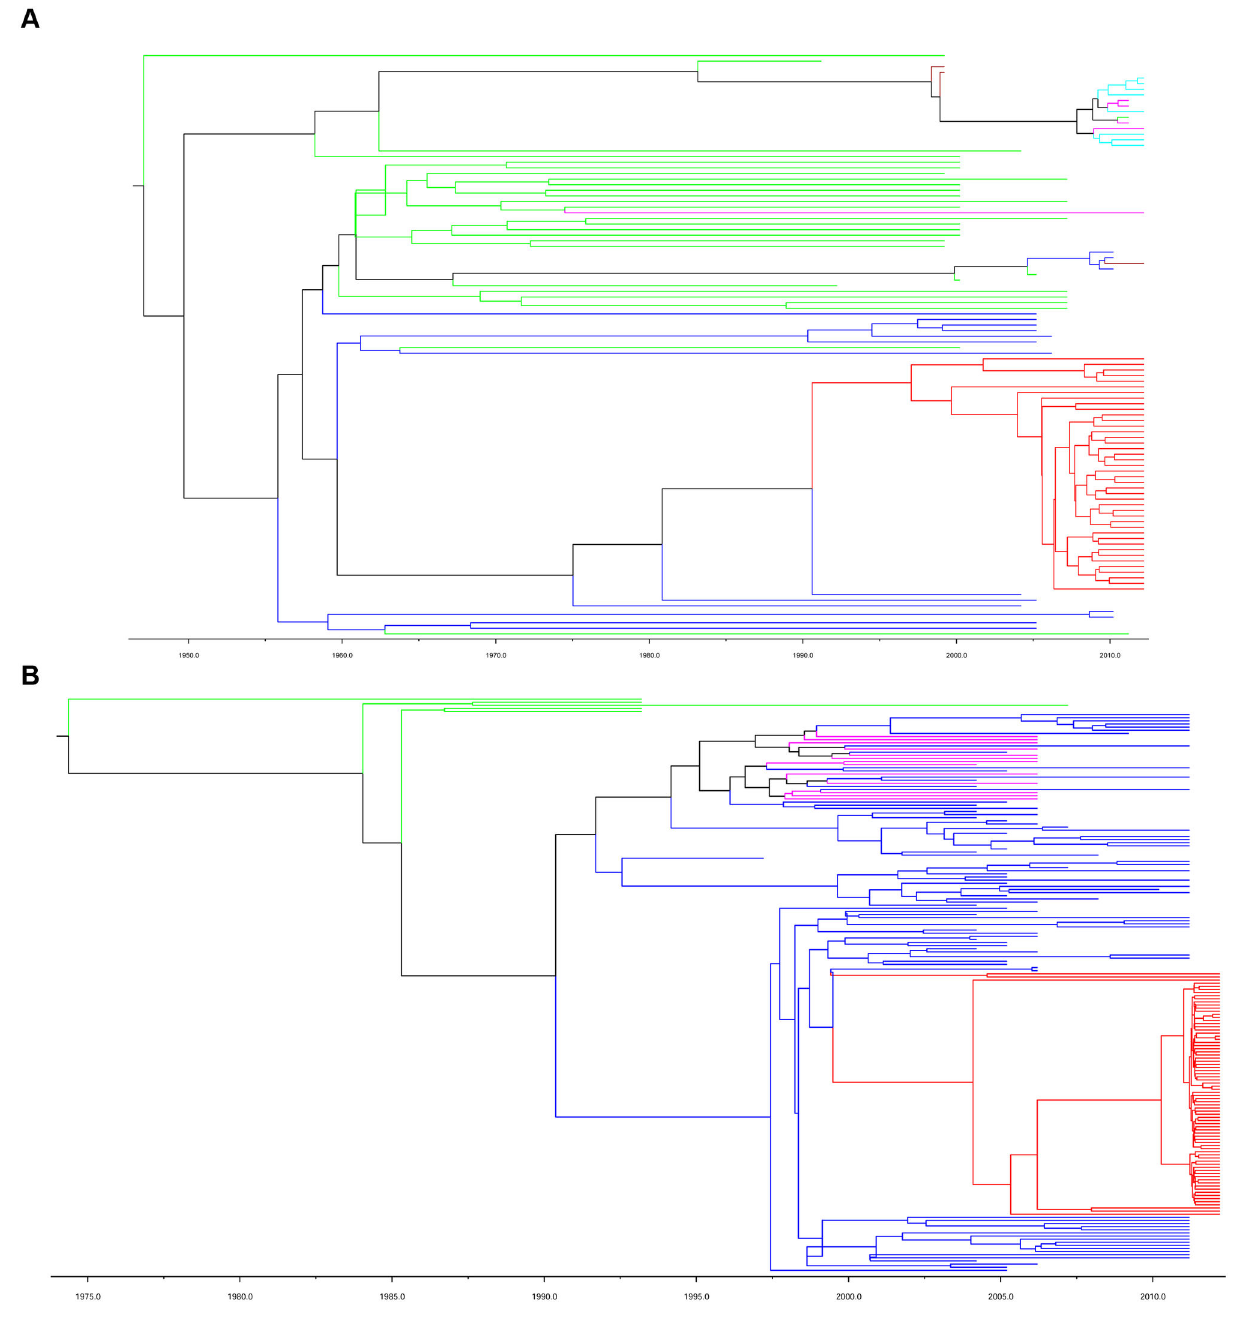
Figure 7. MCC trees of 2a and 6a clusters estimated under the model of Bayesian skyline plot model combinations. The MCC phylogenetic trees for Heyuan 2a cluster (A) and 6a cluster (B) were constructed under the best model combination tested. Branches are colored according to their respective geographic origins: (A). Heyuan 2a cluster, red; China, blue; Japan, green; United States, brown; Spain, Cyan; Denmark, magenta. (B). Heyuan 6a cluster, red; China, blue; Hong Kong, magenta; Vietnam, green. Scaled line indicates the different corresponding years the branches originated. doi: 10.1371/journal.pone.0082304.g007 population. The status of HCV genotype coexistence and the pattern in China. Moreover, according to report, the increase of 6a may affect the overall HCV genotype distribution diversification of HCV transmission modes, such as sexual